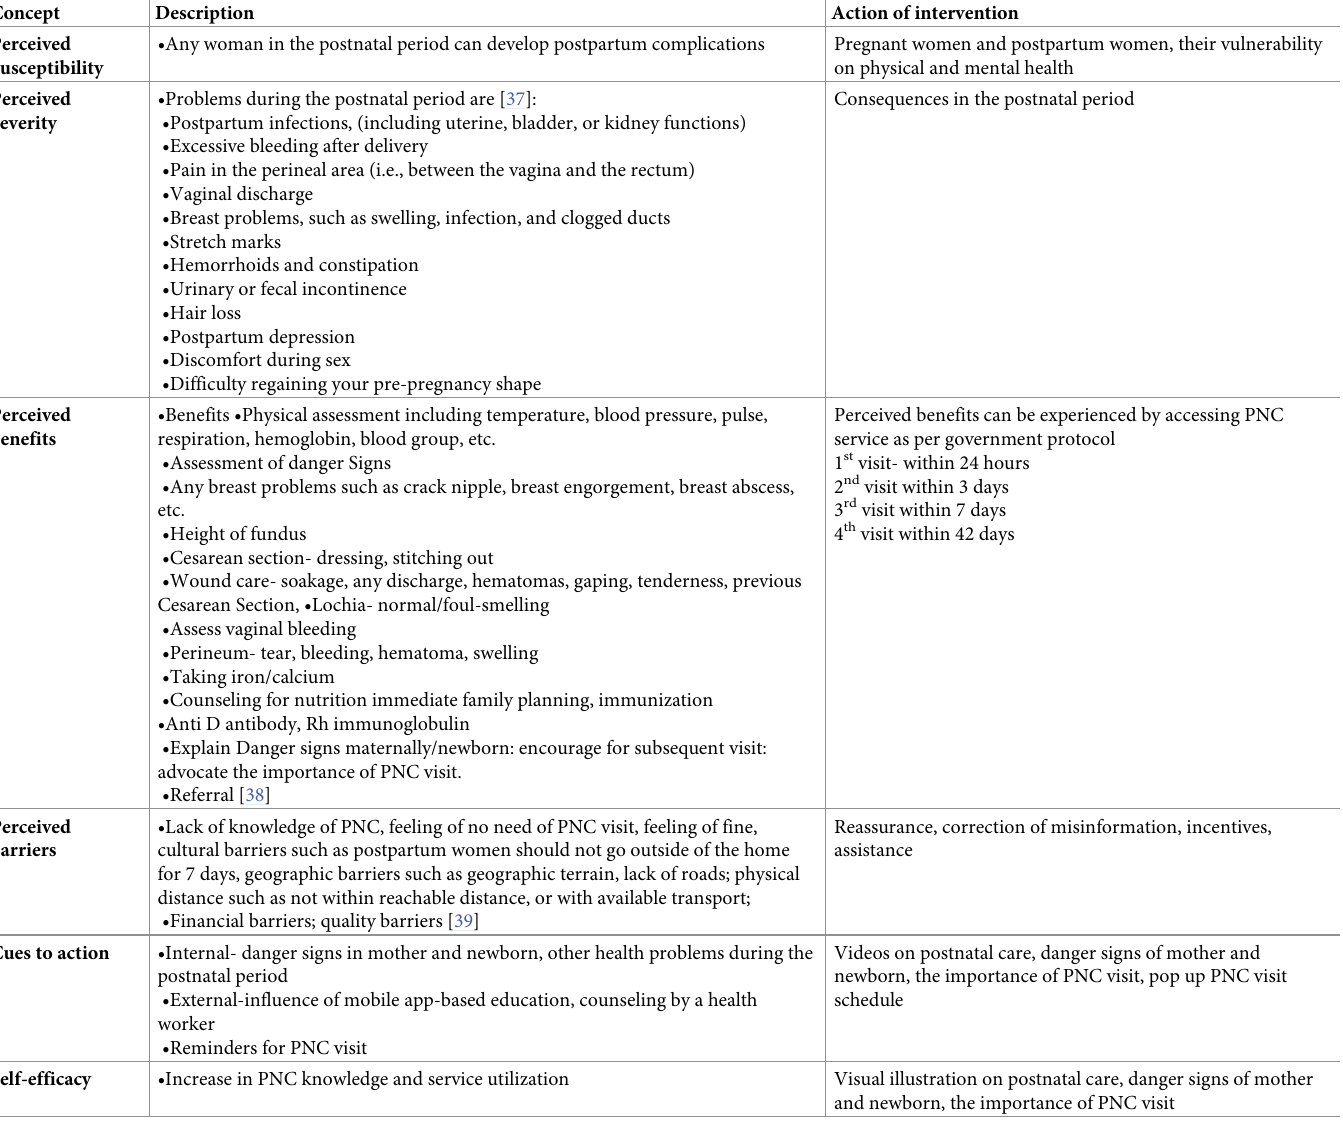
Table 1. Concept and definition of different term of the conceptual framework included in the social media-based